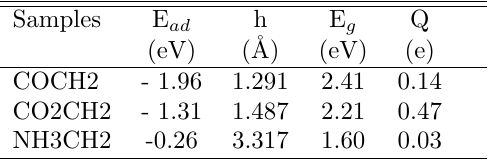
Table 2: Adsorption energy (E ad ), adsorption distance ( h ), band gap (E g ) and charge transfer (Q) from gas molecules to C-H-N:SSPGNR. Samples